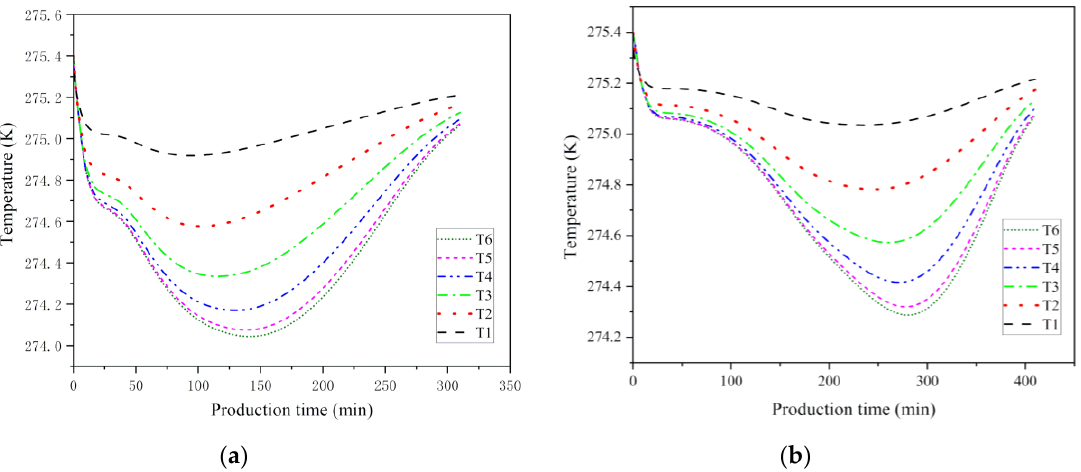
Figure 7. Temperature variation with production time for the mechanical ( a ) uncoupled and (b) coupled model.